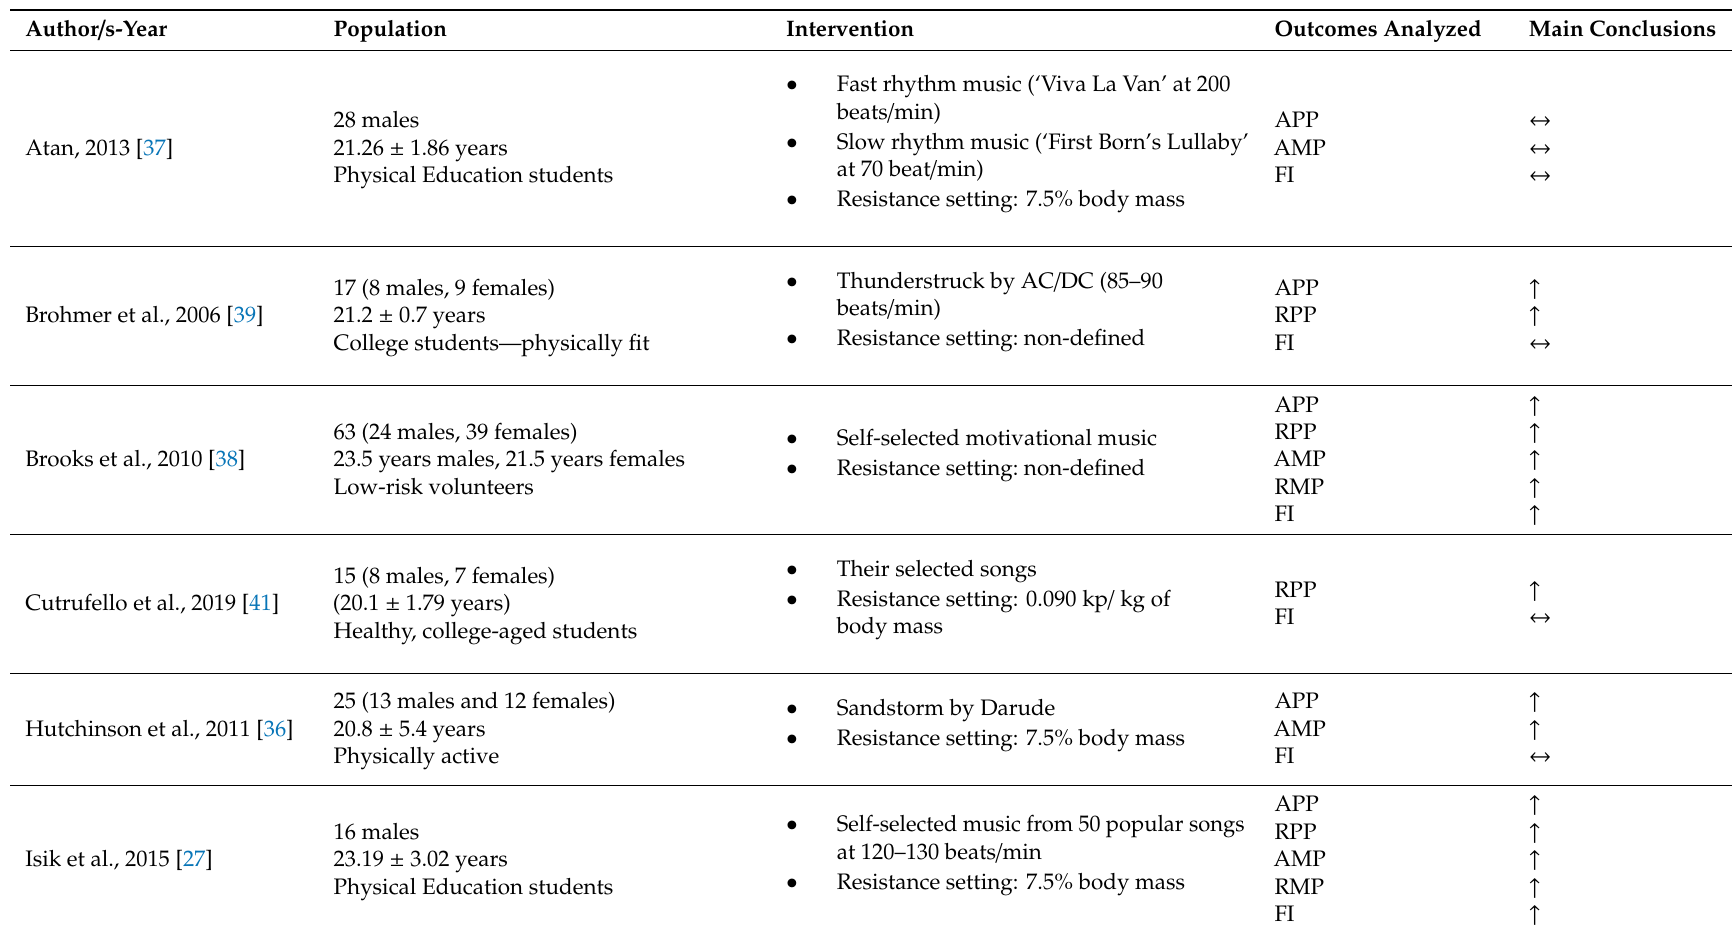
Table 4. Breakdown of studies selected for systematic